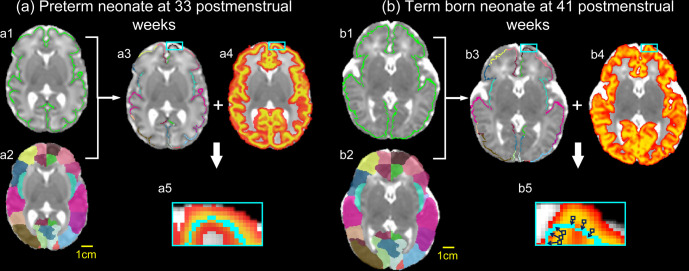
The workflow to parcellate the cortical skeleton and measure the fractional anisotropy (FA) values at the parcellated cortical skeleton from a representative preterm (33 postmenstrual weeks, PMW).(a) and term (41 PMW) (b) born neonate. a1, b1: Green cortical skeleton overlaid on the mean diffusivity map of a 33 PMW (a1) and 41 PMW (b1) neonate brain; a2, b2: The gyral labels with different colors denoting different gyri labels transferred from a neonate atlas (Feng et al., 2019); a3, b3: The labeled cortical skeleton; a4, b4: The cortical tissue probability map; a5, b5: Enlarged map showing alignment of the cortical skeleton (cyan line) and center of cortical mantle. In the places where misalignments occur in b5, measurement of FA at the cortical skeleton (cyan line) was projected from closest voxels with maximum gray matter probability (dark black boxes). The same scale bars at the bottom demonstrate relatively bigger size of the term-born brain at 41 PMW. It is clear from panels (a) and (b) that despite brain size differences, partial volume effects for cortical FA measurements are similar for the preterm and term born brain.